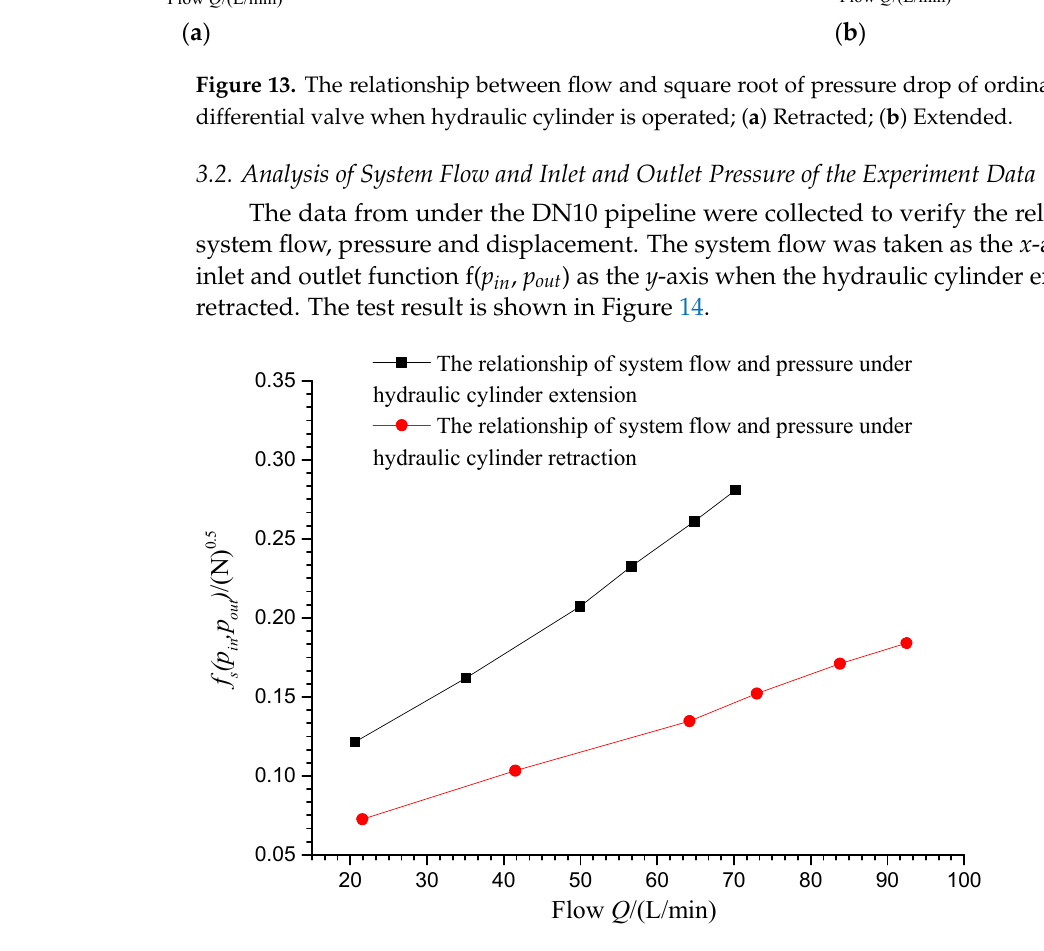
Figure 14. System flow and pressure relationship under DN10 pipeline.